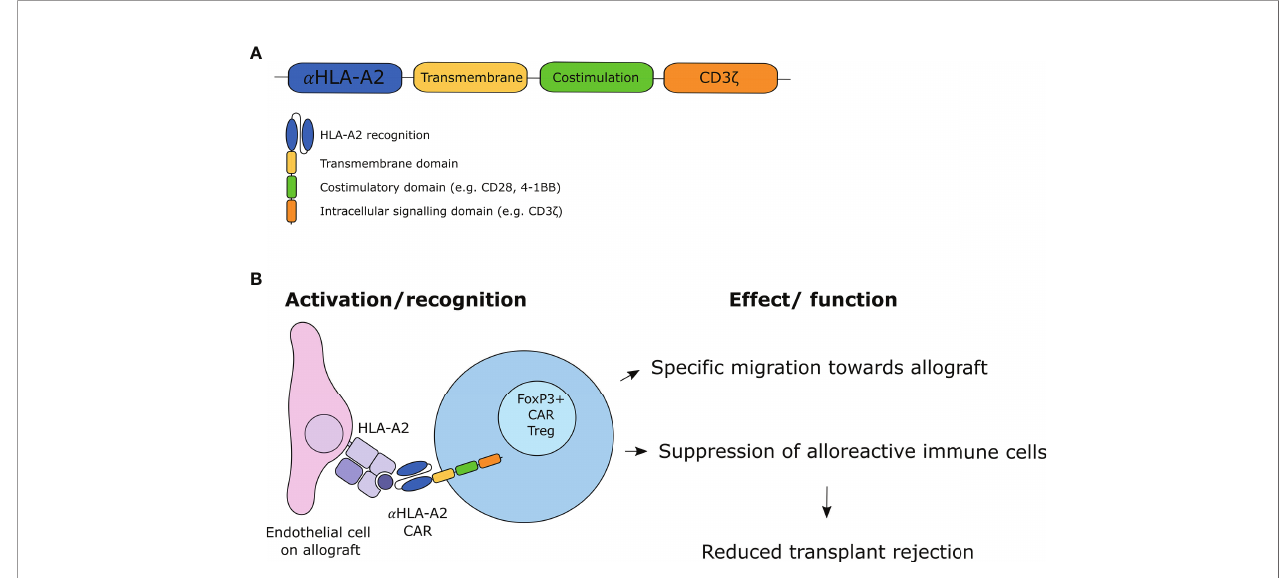
FIGURE 1 | CAR Treg design and working mechanism. (A) Design of second-generation CAR molecule. (B) Proposed mechanism of action of CAR